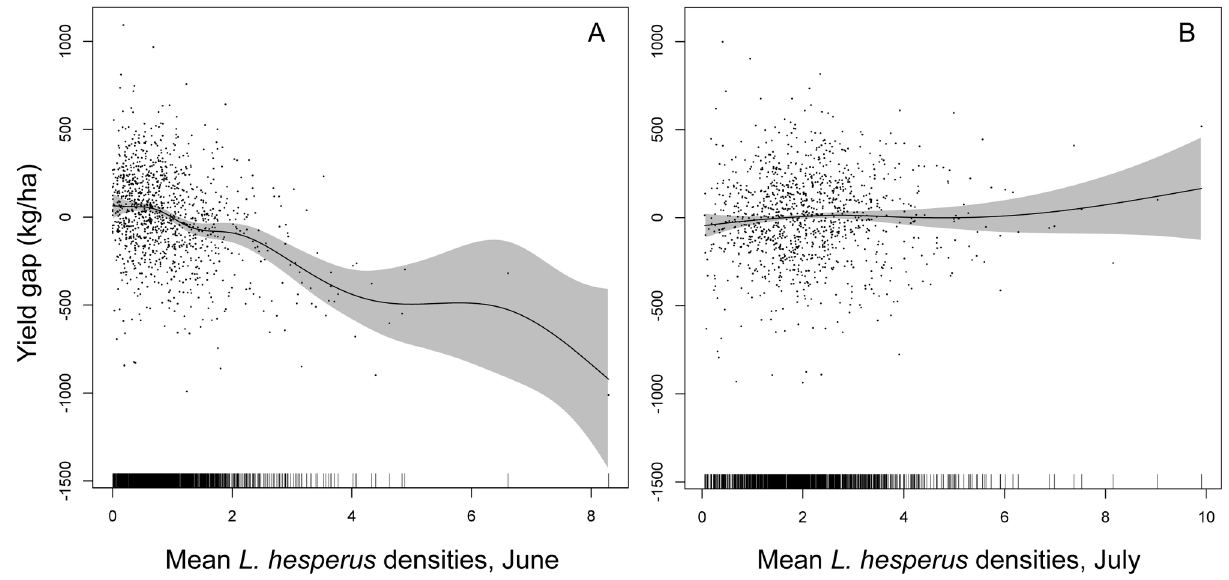
Figure 2. Cotton yield gap and L . hesperus density. Association between the cotton yield gap (difference between the observed and expected yield, after controlling for annual fluctuations in valley-wide yield) and mean L . hesperus densities observed during (A) June, and (B) July. The solid lines are the smooths from the GAM models, and the shaded regions are the 95% confidence